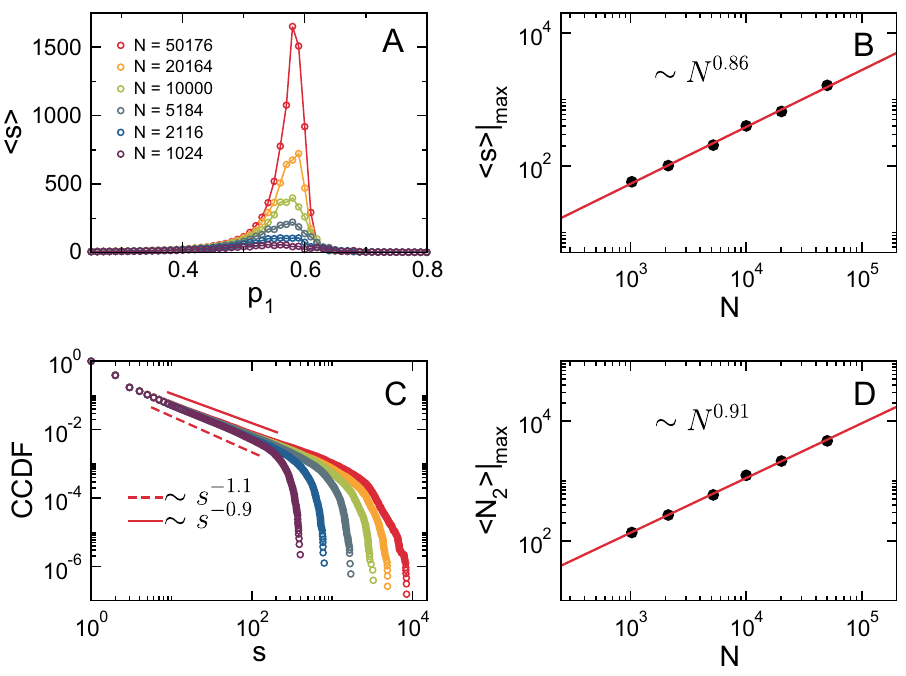
Figure 6. Finite-size scaling analysis of the SE model. ( A ) Susceptibility (cid:31) s (cid:30) as a function of p 1 for different system sizes ( p 2 = 0.7 ). (cid:31) s (cid:30) exhibits a size-dependent maximum at a pseudo–critical value p ∗ 1 ( N ) . ( B ) Log-log plot of � s �| max as a function of N , where the solid red line is a power-law fitting with exponent 0.86 ± 0.02 . ( C ) The CCDF of the cluster size distribution at p ∗ 1 ( N ) for different system sizes, where solid and dashed lines correspond to power-law fits of the central part of the distribution with exponents − 0.9 ( N = 50176 ) and − 1.1 ( N = 1024 ) , respectively. ( D ) Log-log plot of � N 2 �| max as a function of N , where the solid red line is a power-law fitting with exponent 0.91 ± 0.02